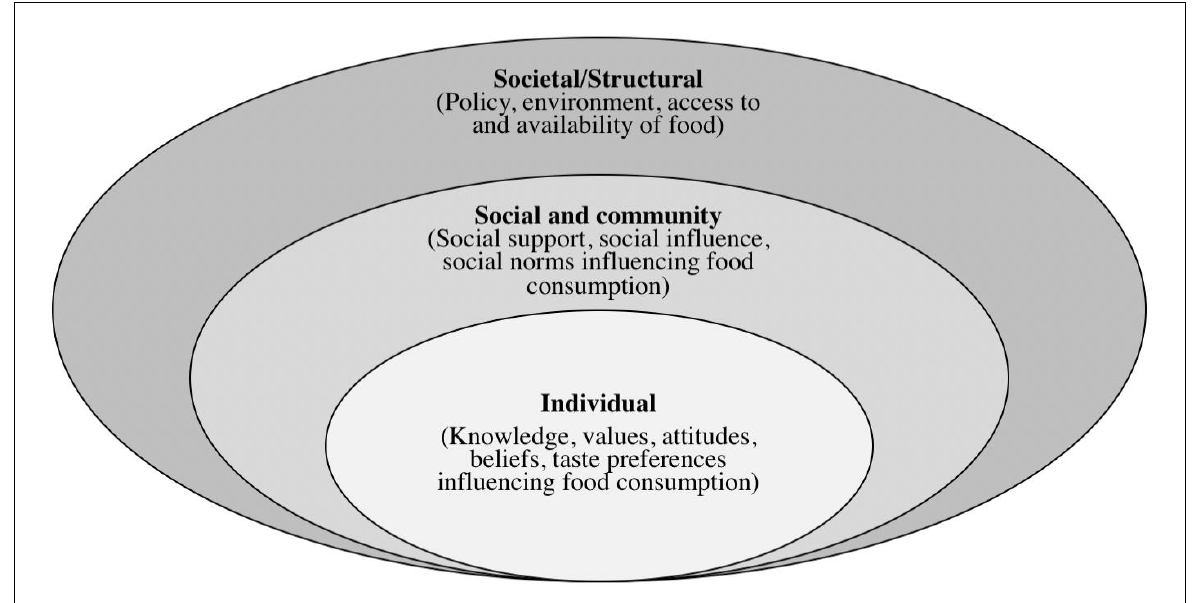
Figure 1. A simplified socioecological model adapted from Bronfenbrenner (1977) and the Centers for Disease Control and Prevention (CDC, 2020). This conceptual framework illustrates the concentric spheres of influence that have been known to impact dietary behaviors at the individual, community, and structural